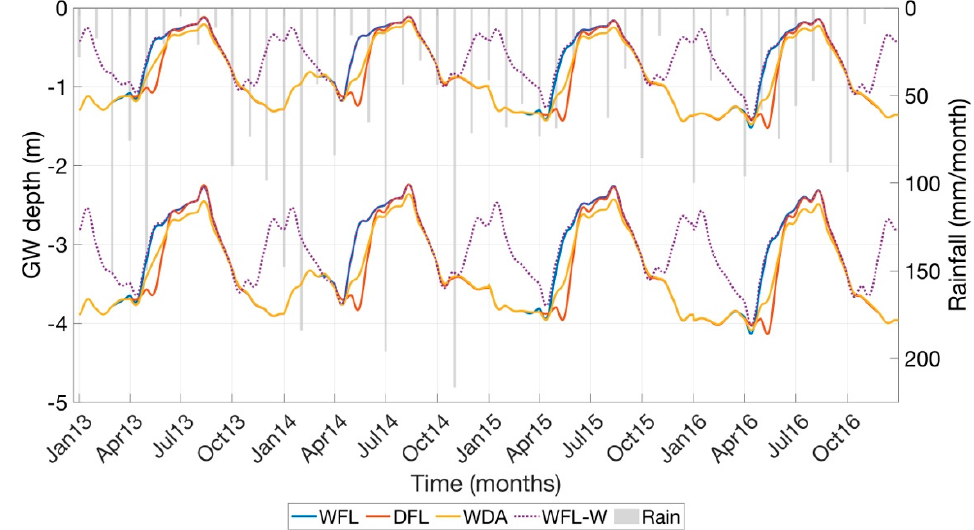
Figure 12. Simulated groundwater levels (both for shallow and deep GW zones) during the agricultural season 2013–2016 for the four irrigation scenarios.